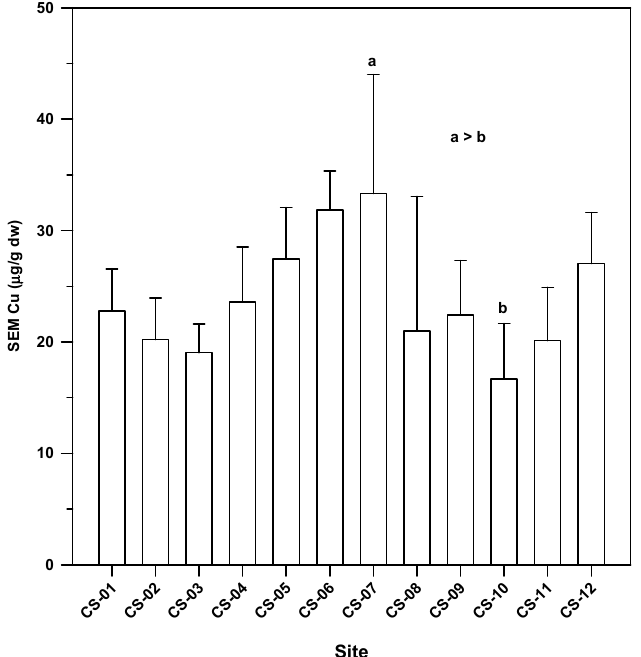
Figure 16. Regression results of sediment SEM copper concentrations (µg/g dry wt) from spring and fall sediment sampling at Cache Slough site CS-12 for the years 2012, 2013 and 2014. (r 2 = 0.666, p = 0.048).